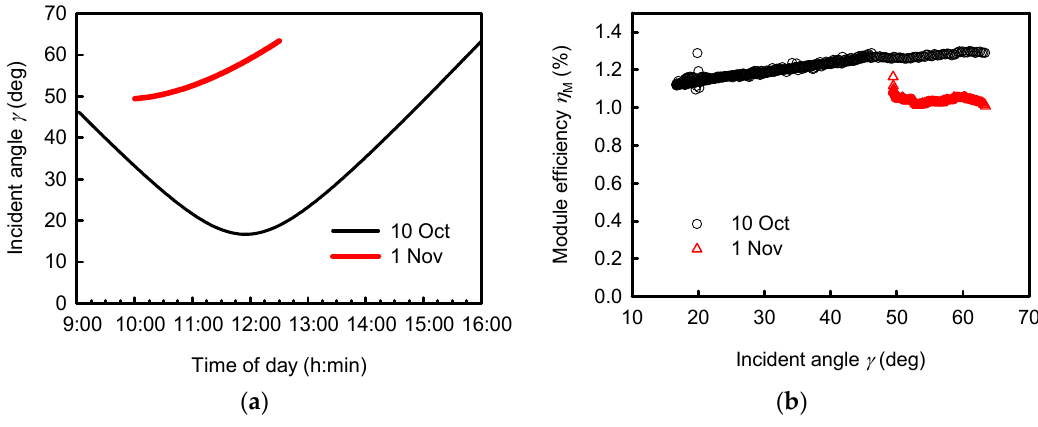
Figure 7. Module efficiency η M with respect to the incident angle γ of direct sunlight: ( a ) angle γ on 10 October at the field plot and on 1 November in the greenhouse; ( b ) η M with respect to γ .